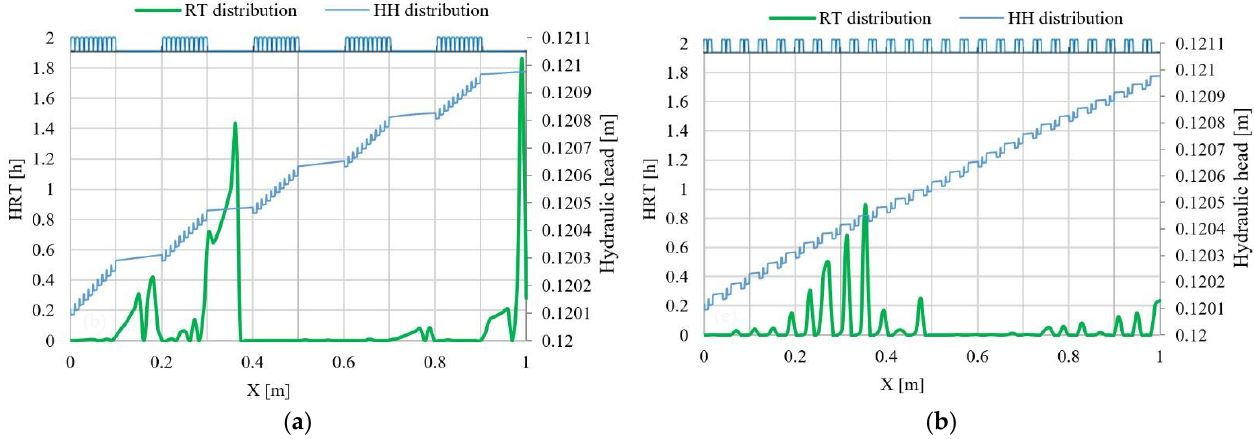
Figure 17. Variation in HRT is shown with the change of distribution of gravel-sand portion in streambed. Model setups zgst5 × 10-5 ( a ) and zgst5 × 10-25 ( b ) are used to compute the HRT distribution.